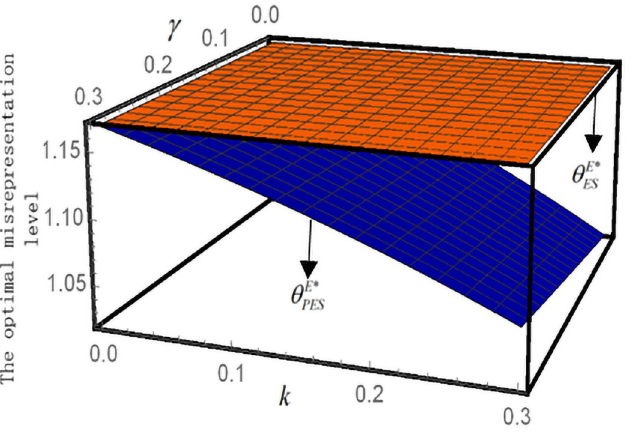
Fig 4. The impact of k and γ on the optimal misreport